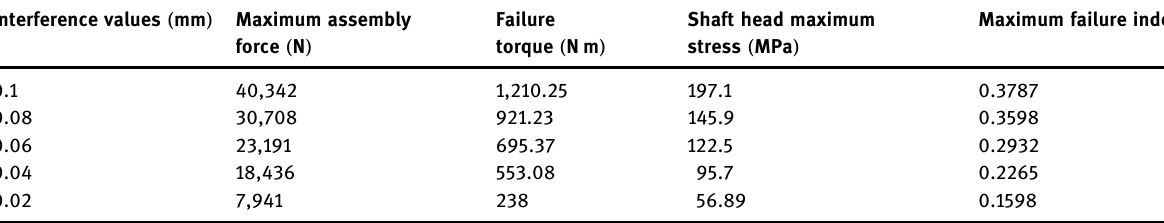
Table 6: Evaluation index of interference fi t joints at di ff erent interference values Interference values ( mm ) Maximum assembly